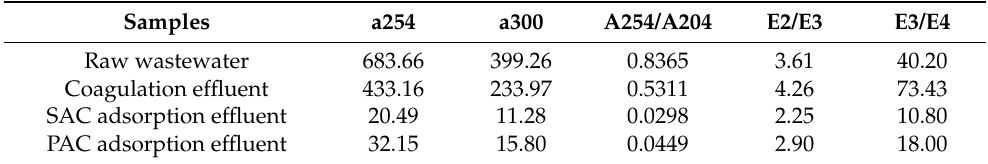
Table 3. Spectral characteristic parameters of BTCW and effluent with coagulation and SAC and PAC treatments.